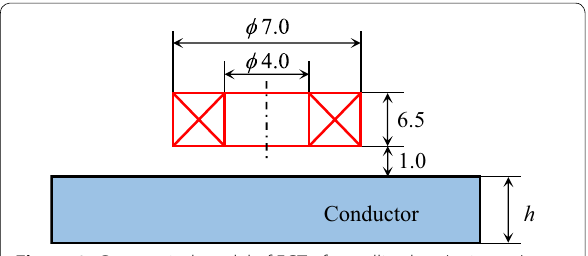
Figure 2 Geometrical model of ECT of metallic plate (unit: